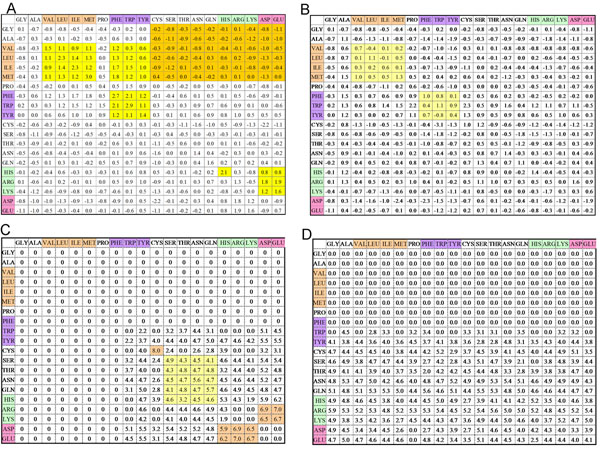
Knowledge-based protein-protein interacting scoring matrices: (A) sidechain-sidechain van-der Waals scoring matrix; (B) sidechain-backbone van-der Waals scoring matrix; (C) sidechain-sidechain special-bond scoring matrix; (D) sidechain- backbone special-bond matrix scoring. The sidechain-sidechain scoring matrices are symmetric and sidechain-backbone scoring matrices are nonsymmetric. For sidechain- sidechain van-der Waals scoring matrix, the scores are high (yellow blocks) if large-aliphatic residues (i.e. Val, Leu, Ile, and Met) interact to large-aliphatic residues or aromatic residues (i.e. Phe, Tyr, and Trp) interact to aromatic residue. In contrast, the scores are low (orange blocks) when nonpolar residues interact to polar residues. For sidechain-sidechain special- bond scoring matrix, the scores are high when an interacting resides (i.e. Cys to Cys) form a disulfide bond or basic residues (i.e. Arg, Lys, and His) interact to acidic residues (Asp and Glu). The scoring values are zero if nonpolar residues interact to other residues.